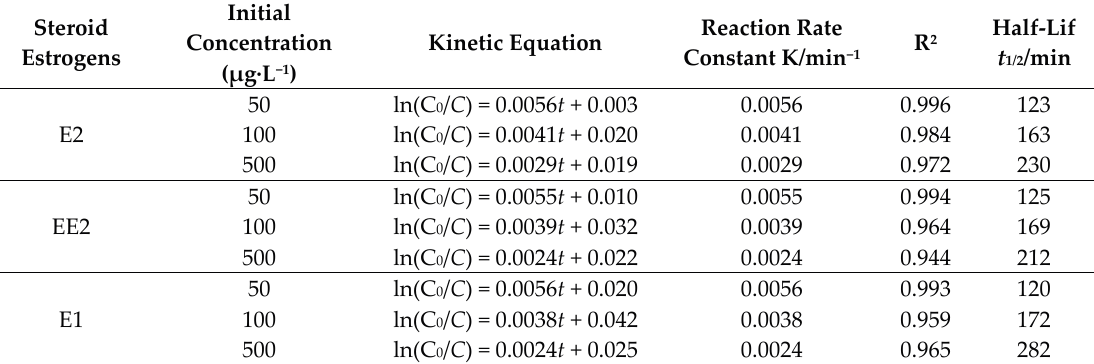
Table 3. Parameters of the degradation kinetic model of SEs under different initial concentrations.